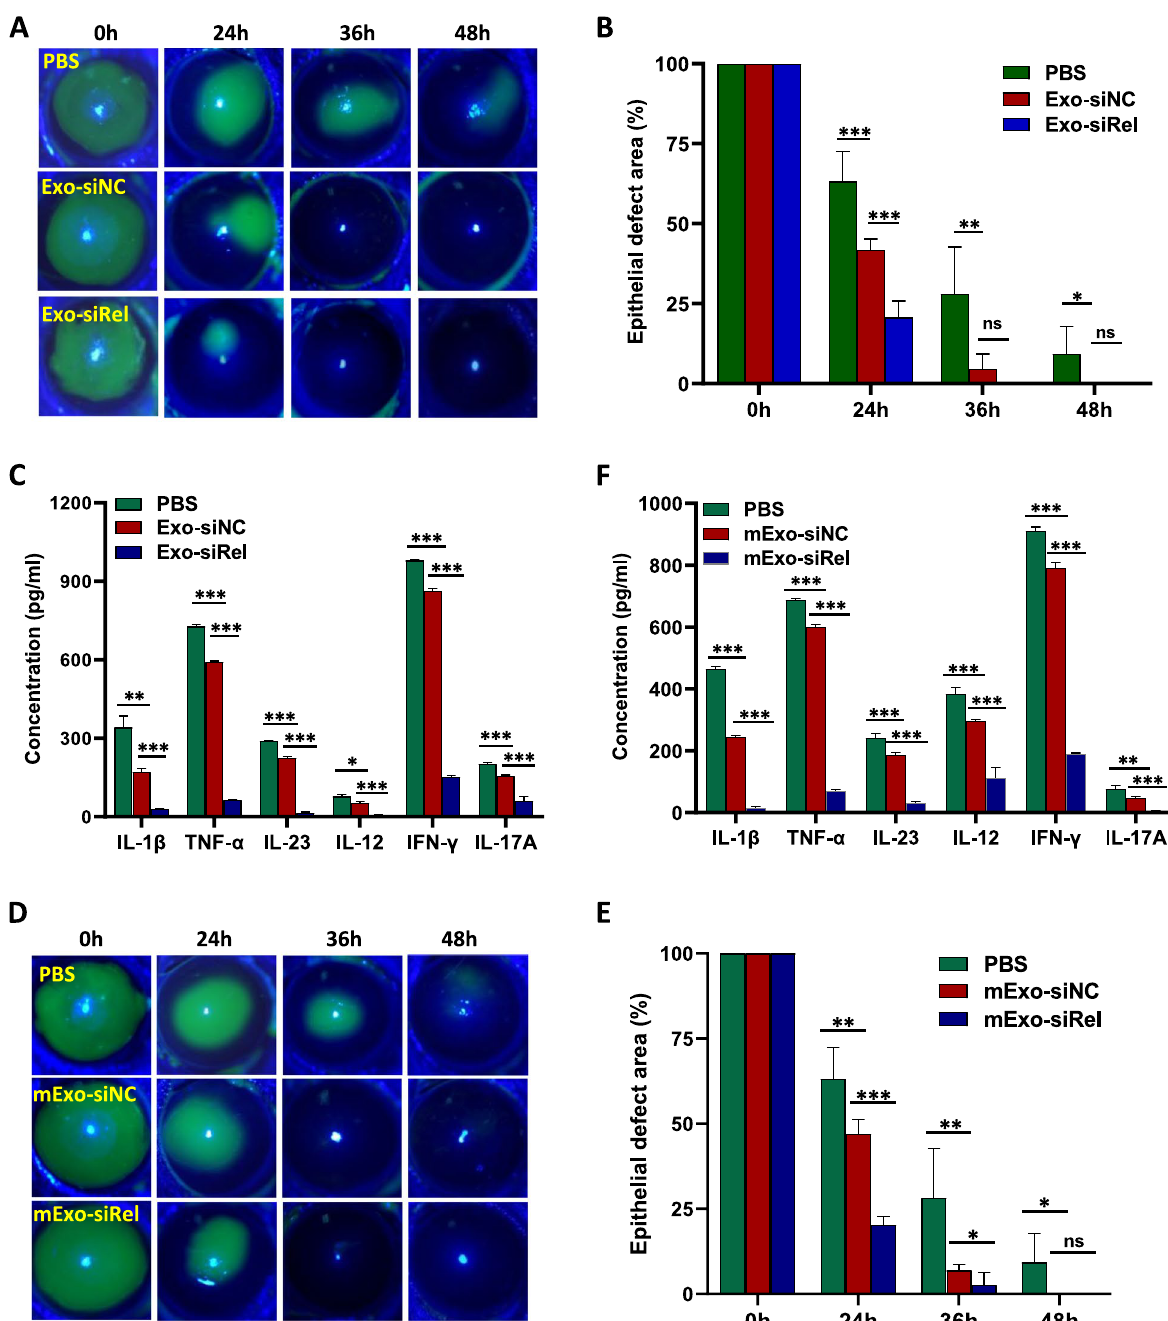
Fig. 4 Topical treatment on corneal surface with siRel-loaded exosomes displays superior efficacy in accelerating conventional corneal wound healing. A corneal epithelial wound healing model was established in normal mice. A – C Exosomes were isolated from the supernatant of siNC ( n 6) or siRel-transfected ( n 6) hMSCs and topically applied to the corneal surface immediately after corneal epithelial scraping and at 12 h, 24 h, = = and 36 h hereafter. PBS-treated mice ( n 6) were used as control. Corneal epithelial wounds were stained with fluorescein sodium and examined = under a slit lamp microscope at the indicated time points ( A ). Statistical analysis was performed on the corneal epithelial defect area using Image J software ( B ). Corneal tissue extracts were prepared at 24 h after corneal epithelial scraping and the production of inflammatory cytokines as indicated in the figure was determined by ELISA ( C ). D–F hMSC-derived exosomes were transfected with either siNC ( n 6) or siRel ( n 6) and = = topically applied to the corneal surface as described in A–C . PBS-treated mice ( n 6) were used as control. Corneal epithelial wound staining ( D ), = statistical analysis of corneal epithelial defect area ( E ) , and detection of inflammatory cytokine production in corneal tracts ( F ) were then performed also as described in A–C . For A , C , D , and F , results shown are representative of two independent experiments. For B and E , results shown are combined from two independent experiments. * P <0.05, ** P <0.01, *** P